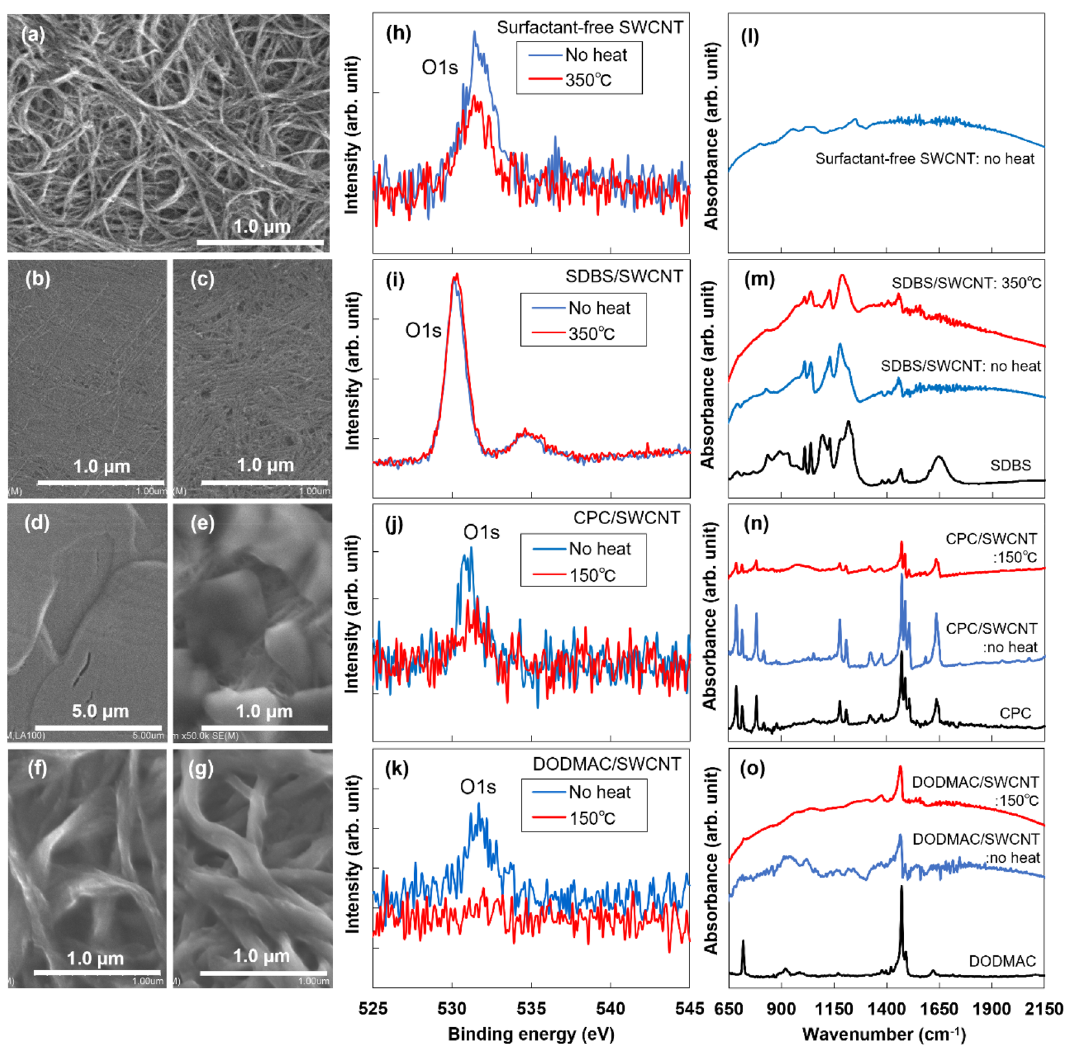
Figure 3. Surface morphologies of SWCNT films with different surfactants and heat-treatment temperatures observed by SEM. ( a) Surfactant-free, no heat treatment. ( b) SDBS, no heat treatment. c SDBS, 350°C. ( d) CPC, no heat-treatment. ( e) CPC, 150°C. ( f) DODMAC, no heat treatment. ( g) DODMAC, 150°C. Intensities of O1s spectra of SWCNT films with different surfactants and heat-treatment temperatures, observed using X-ray photoelectron spectroscopy (XPS). ( h) Surfactant-free. ( i) SDBS. ( j) CPC. ( k) DODMAC. Absorbance of SWCNT films with different surfactants and heat-treatment temperatures, observed using FTIR. ( l) Surfactant- free. ( m) SDBS. ( n) CPC. ( o)